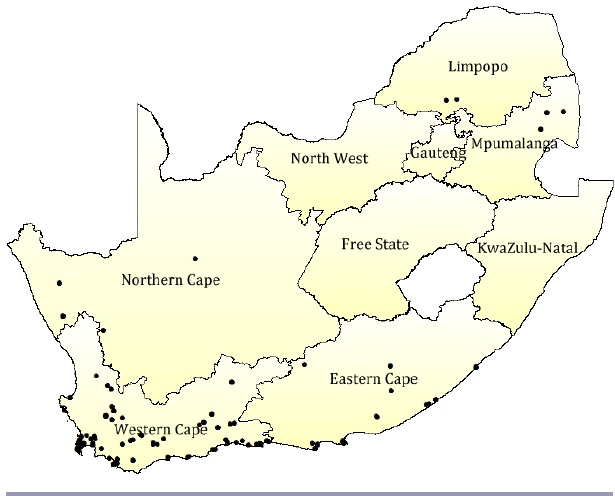
Fig. 1 . Site map of respondent locations across South